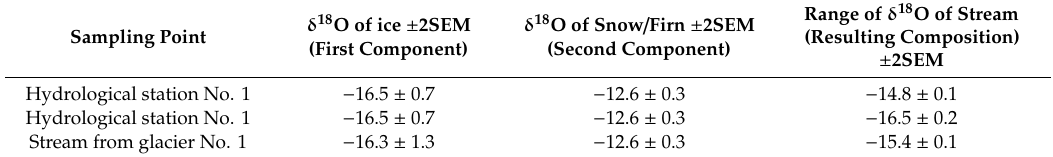
Table 3. The values of the variables of the isotopic balance equation used in isotope separation. Sampling Point